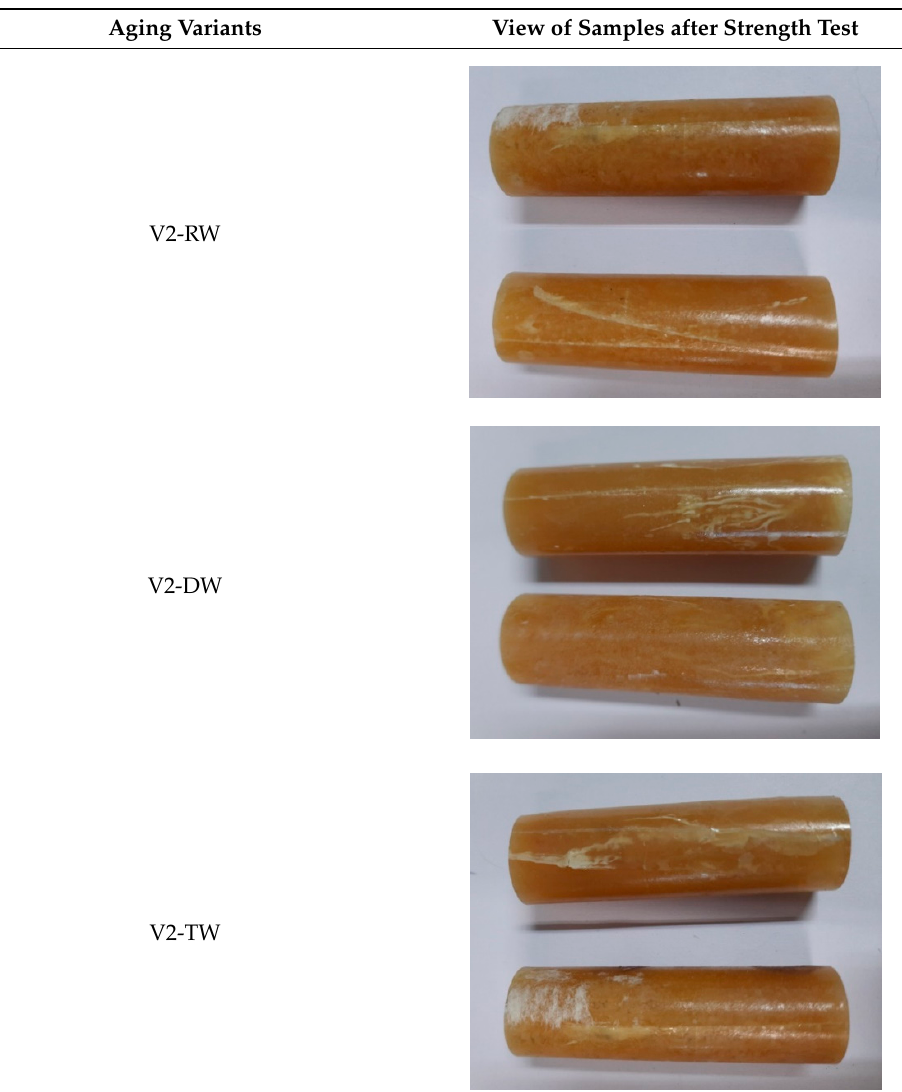
Table 9. View of the shape of the Epidian 57/PAC/10:1 epoxy compound samples—variant II.